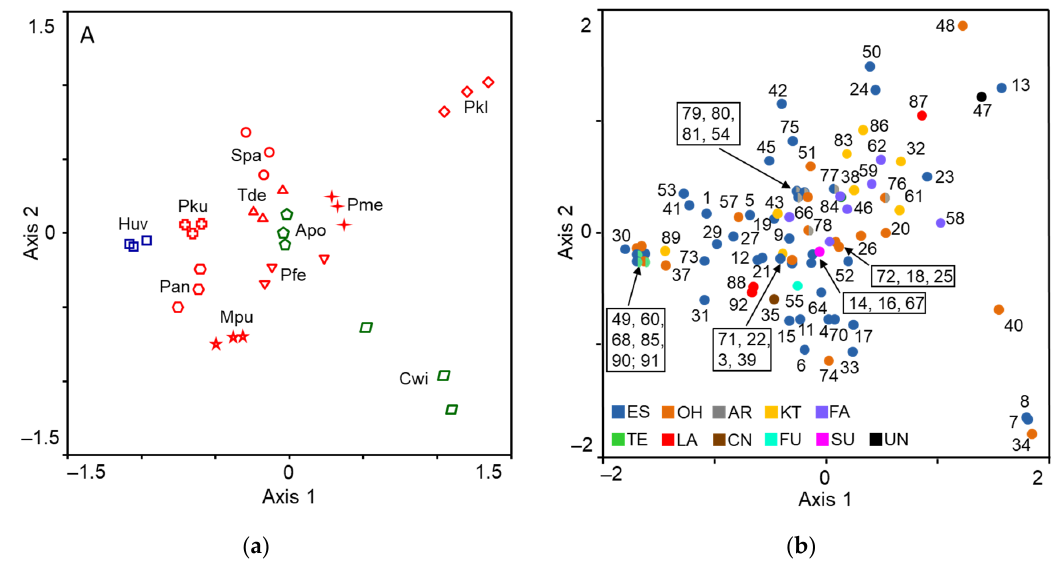
Figure 2. Multidimensional scaling plots: ( a ) eleven yeast species (each represented by three differ- ent isolates); ( b ) volatile compounds produced by yeasts. Volatiles were sampled from the head- space by SPME. Pku— Pichia kudriavzevii , Pfe— P. fermentans , Pan— P. anomala , Pkl— P. kluyveri , Pme— P. membranifaciens , Spa— Saccharomyces paradoxus , Tde— Torulaspora delbrueckii , Mpu— Metschnikowia pulcherrima , Huv— Hanseniaspora uvarum , Apu— Aureobasidium pullulans , Cwi— Cryp- tococcus wieringae . Apu and Cwi yeasts are more common on unripe fruits and their symbols are coloured green, Huv yeasts are the most common on medium-ripe and ripe fruits and are indicated by the blue colour, and the red colour represents yeasts, the most common on ripe fruits. The name